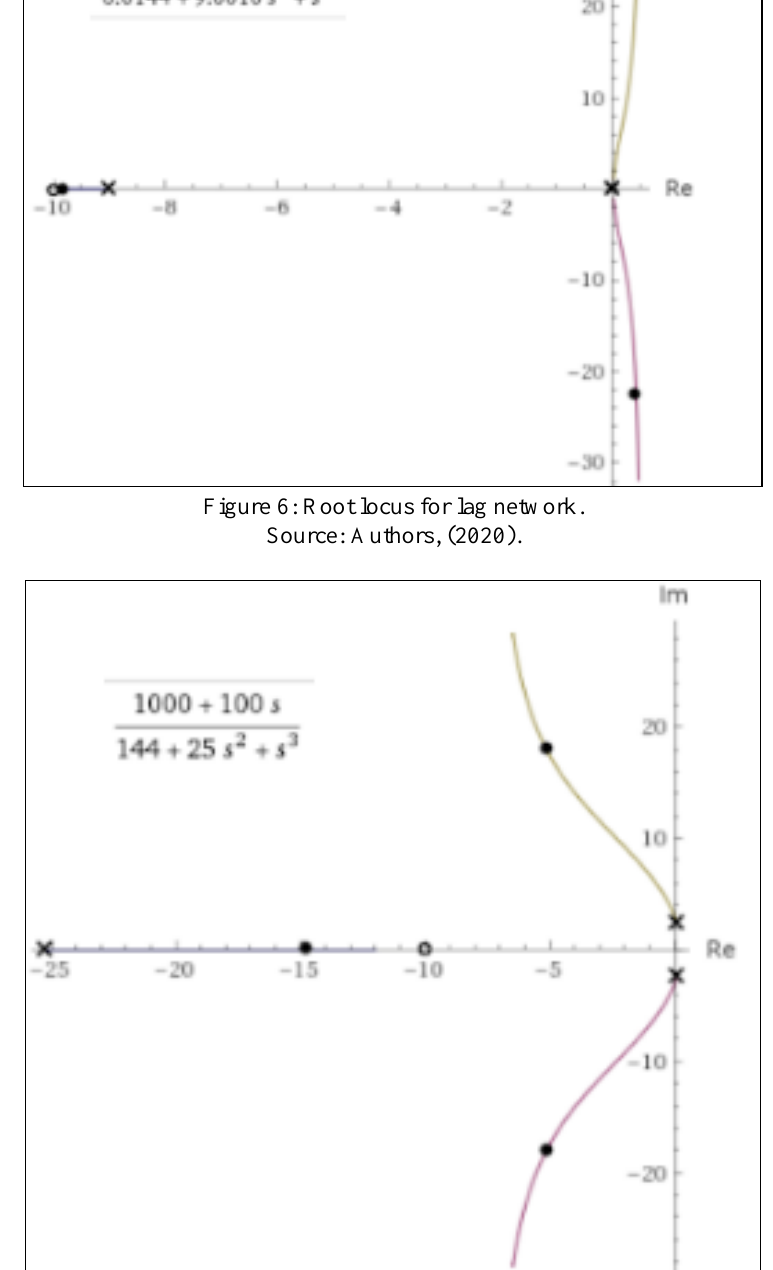
Figure 7: Root locus for lead